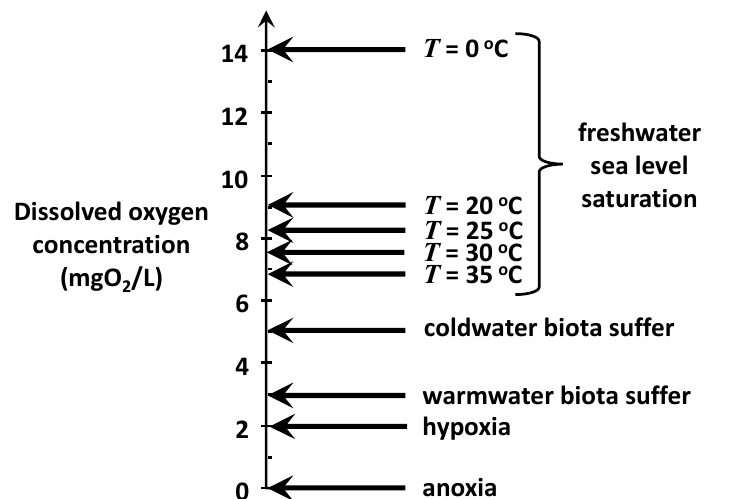
Figure 3. A dissolved oxygen concentration (mgO 2 /L) scale showing several key levels related to establishing oxygen concentration targets needed to maintain ecosystem health and protect designated uses.